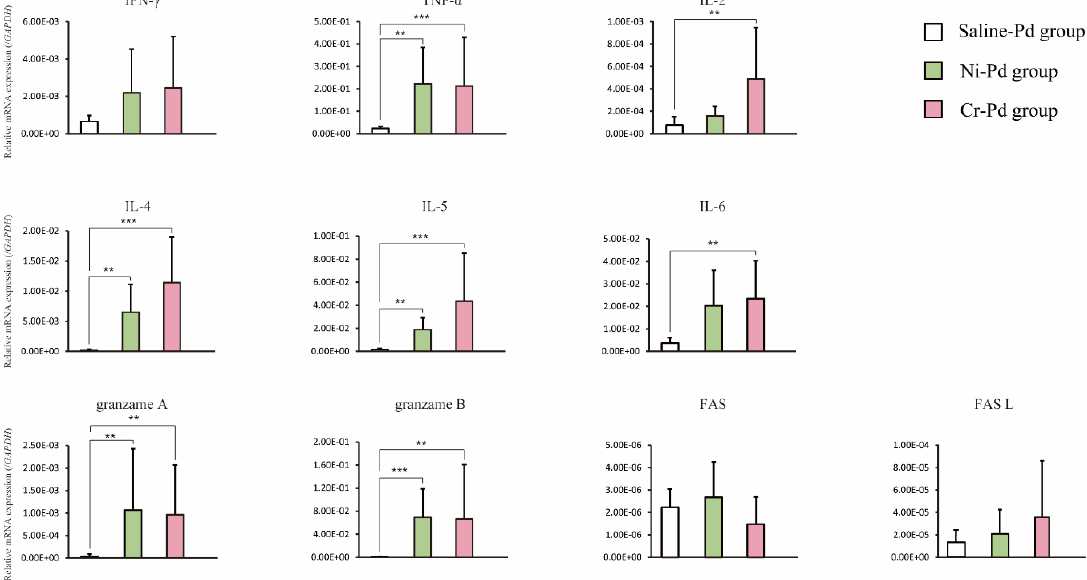
Figure 5. Expression levels of T cell cytokines, cytotoxic granules, and apoptosis-related genes in the mouse model of cross-reactive metal allergy. The expression levels of Th1 cytokines (interferon gamma [IFN- γ ], tumor necrosis factor alpha [TNF- α ], and interleukin [IL]-2), Th2 cytokines (IL-4, IL-5, and IL-6), cytotoxic granules (granzyme A and B), and apoptosis-related genes (Fas and Fas ligand [L]) were measured by qPCR analysis in the Ni-Pd Cr-Pd and Saline-Pd groups. Bars and error bars indicate the mean plus standard deviation. Statistical significance was tested by Dunn’s test (* p < 0.05, ** p < 0.01, *** p < 0.001).